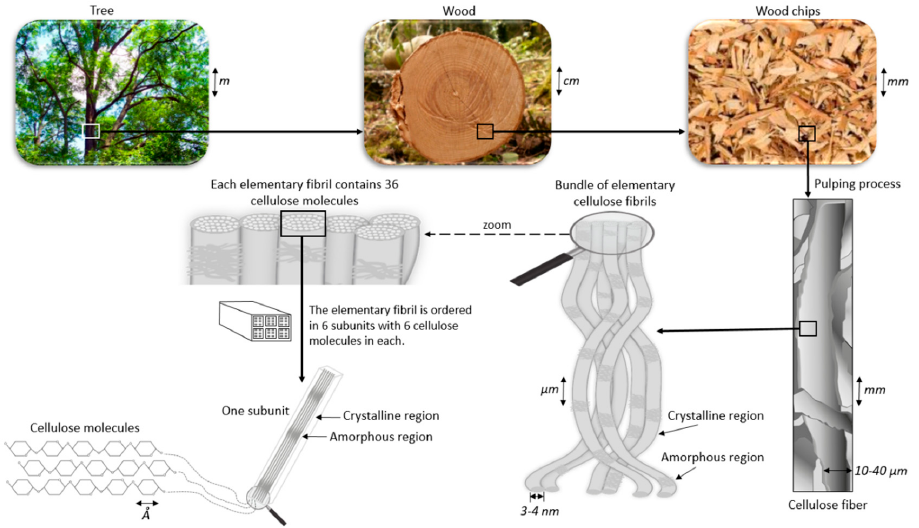
Figure 2. Illustration of nanocellulose. The cellulose fiber consists of crystalline and non-crystalline